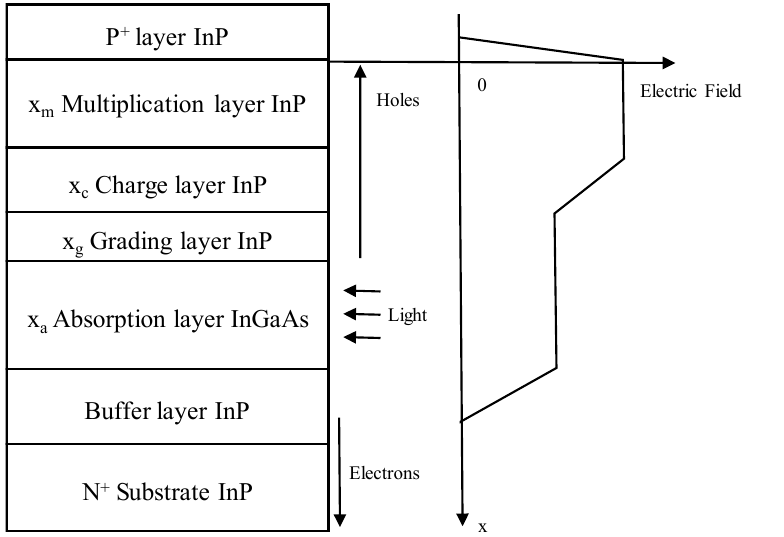
Figure 6. Schematic diagram and electric field distribution of separate absorption, grading, charge, and multiplication (SAGCM) InGaAs/InP APDs.